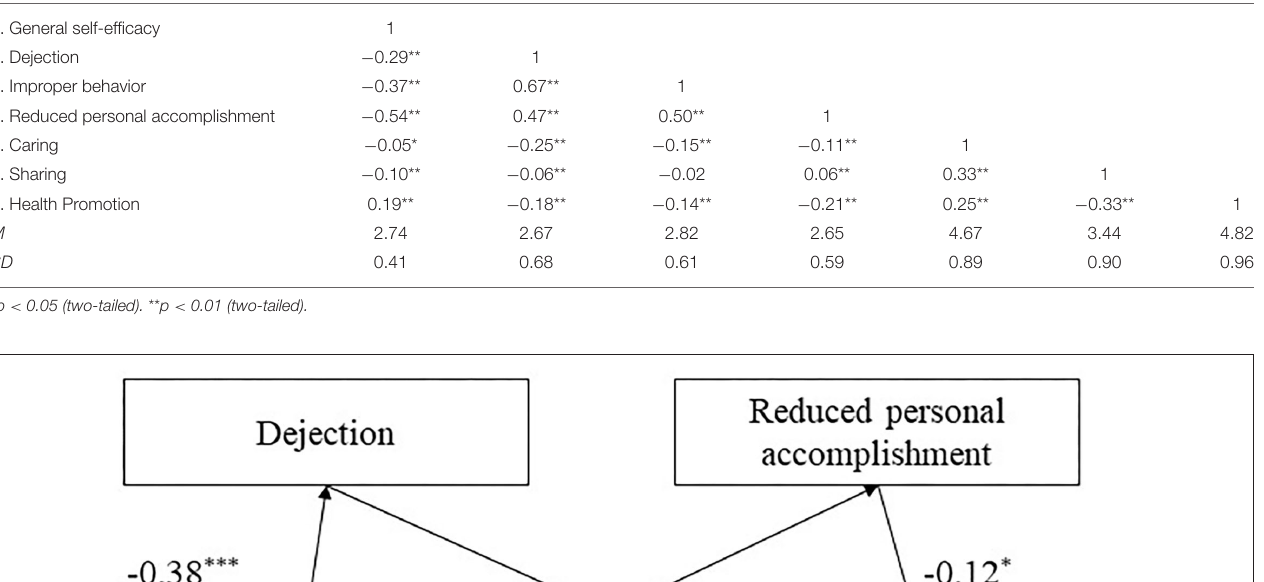
TABLE 1 | Descriptive statistics and inter-correlations between variables ( n = 2,231). Variable 1